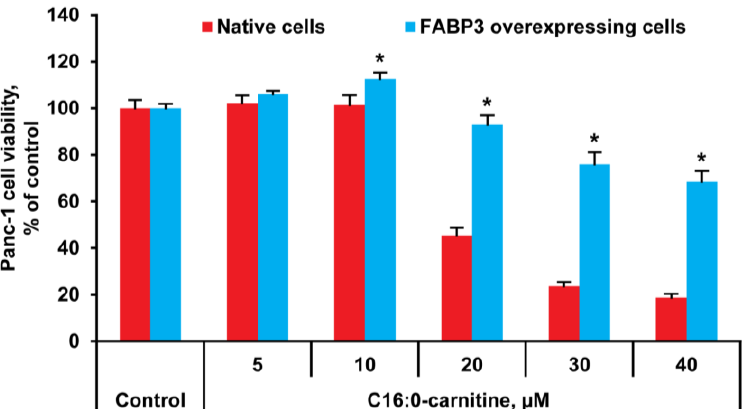
Figure 3. Toxicity of C16:0-carnitine in native and heart-type fatty acid-binding protein (FABP3)- overexpressing PANC-1 cells after 4 h of incubation. Data are shown as the mean ± SEM of 3 independent experiments in at least 6 technical replicates. * indicates a significant difference compared to the native cells at the respective concentration of C16:0-carnitine.